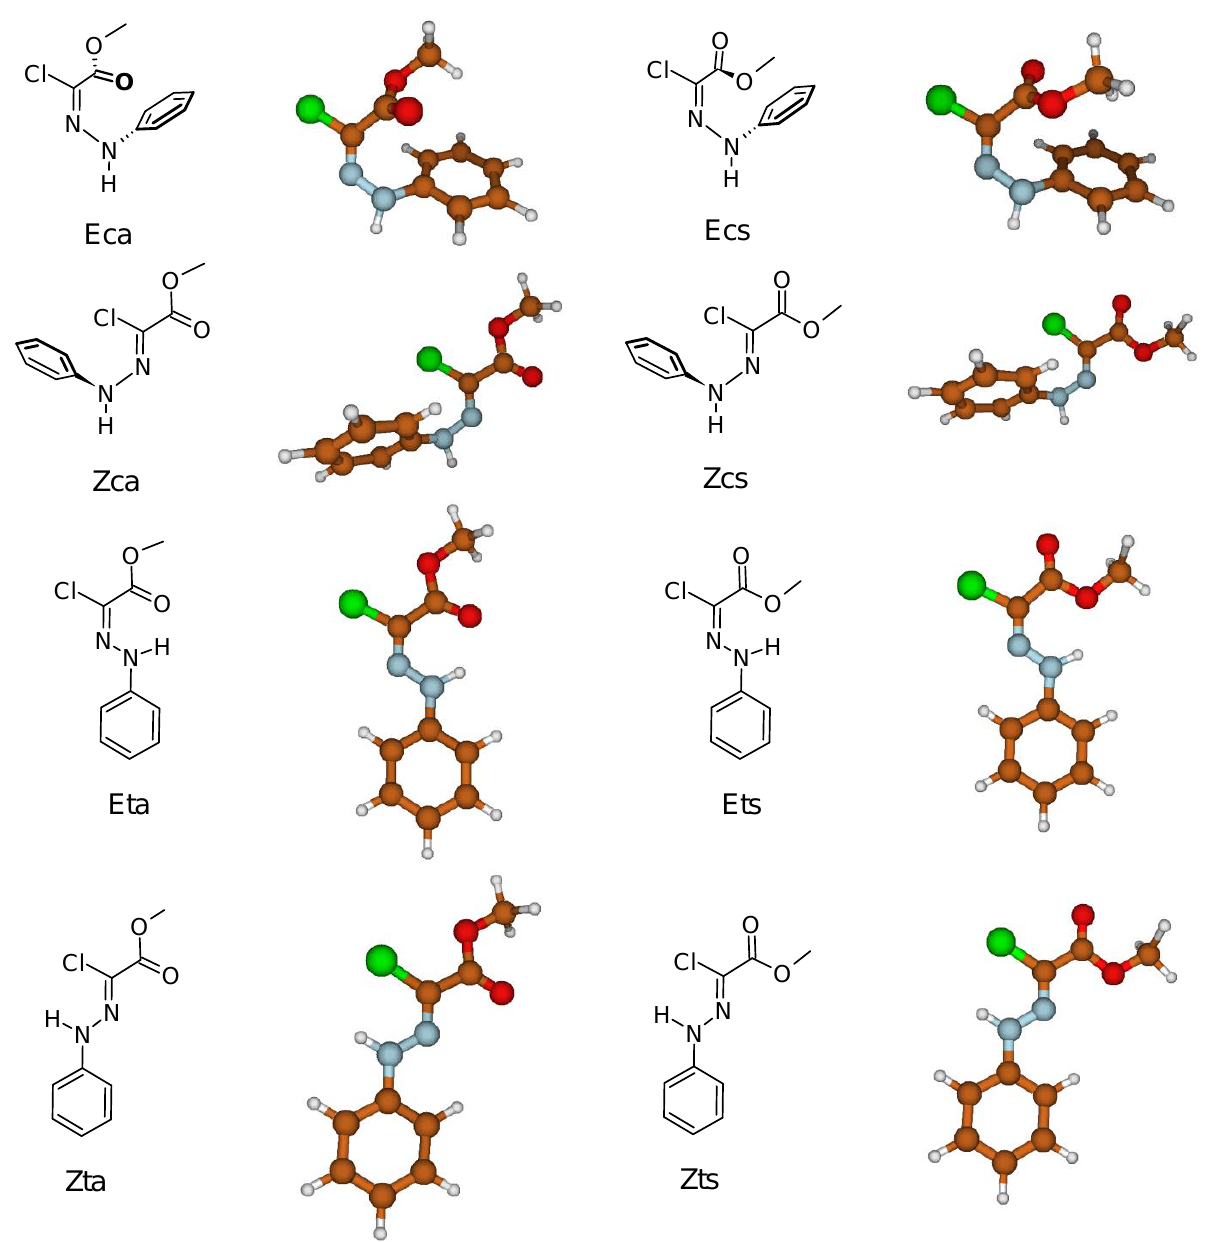
Figure 6. Minimum energy structures of 1 calculated at the ω B97M-D4/cc-pVTZ level. Table 2. Energetics of the minimum energy structures of 1 calculated at the ω B97M-D4/cc-pVTZ level. The reaction free energy ∆ G (kJ/mol) is listed along with the relative population at 298 K. ∆ G (kJ/mol) Rel.